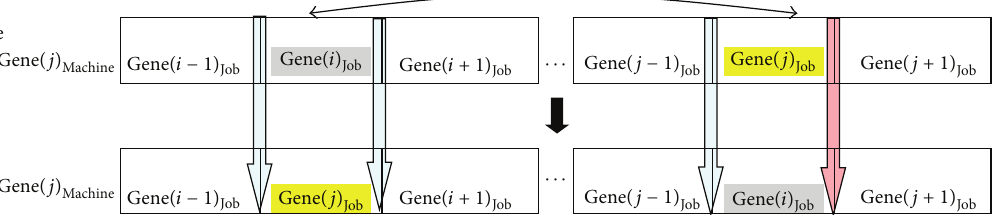
Figure 6: Intermachine interchange and nonadjacent jobs situation.